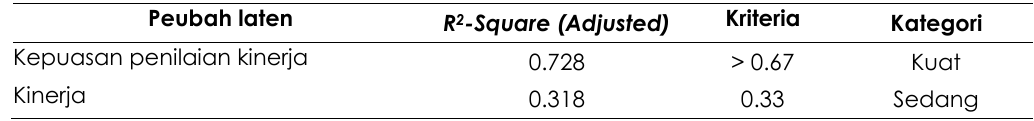
Tabel 7. Nilai R 2 model struktural